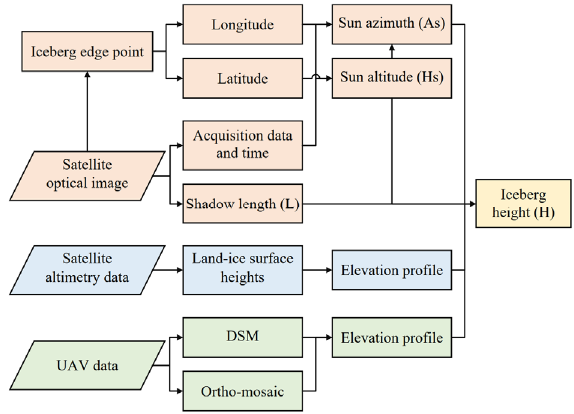
Figure 2 . Flowchart of iceberg height retrieval by three different